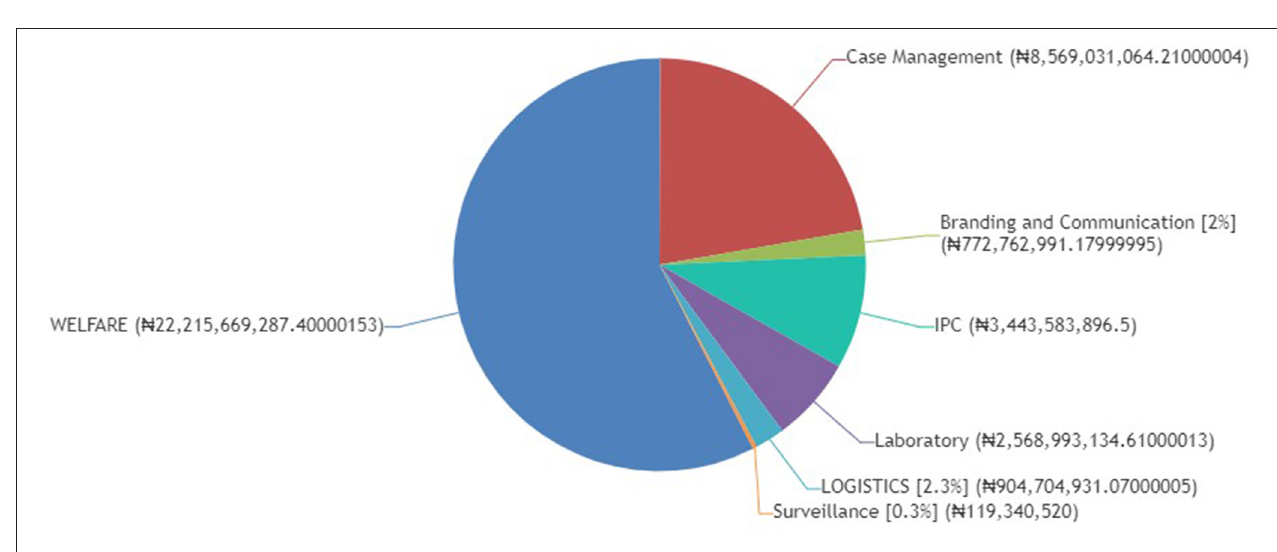
FIGURE 2 | CACOVID expenditure. Source: